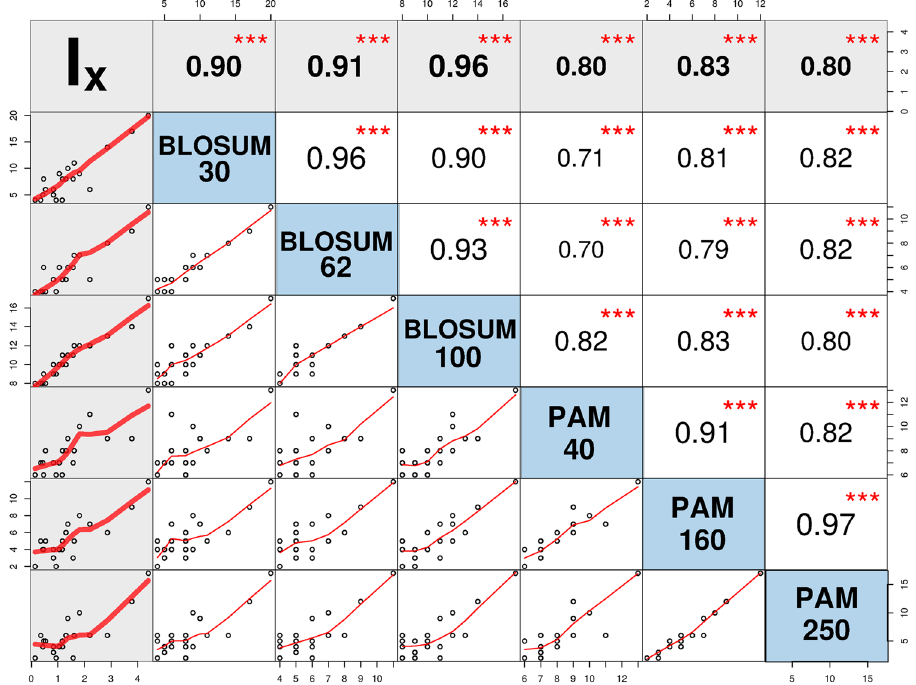
Figure 6. Correlation matrix plot with significance levels between the replacement inertia ( I X ) and the mutability of a representative set of BLOSUM and PAM matrices. The lower triangular matrix is composed by the bivariate scatter plots with a fitted smooth line. The upper triangular matrix shows the Pearson correlation plus significance level (as stars). Each significance level is associated to a symbol: p-values 0.001 ( *** ), 0.01 ( ** ), 0.05 ( * ). This plot was generated with the Performance Analytics package in R program 57 . The correlation matrix for the complete mutability set is plotted in Supplementary Fig.